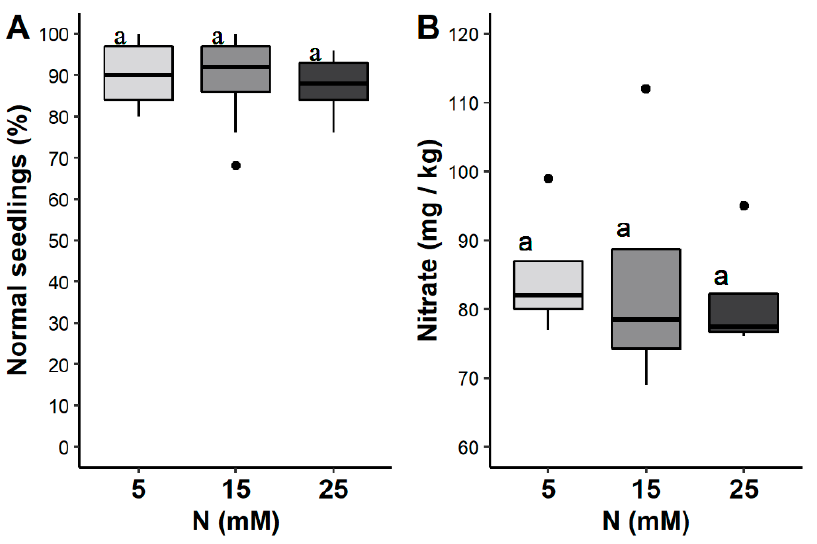
Figure 3. Normal seedlings percentage ( A ) and nitrate content ( B ) of seeds from tomato plants fertigated with solutions of 5, 15 or 25 mM nitrogen (N) concentration. Different letters represent a significant difference ( p < 0.05). Dots represent